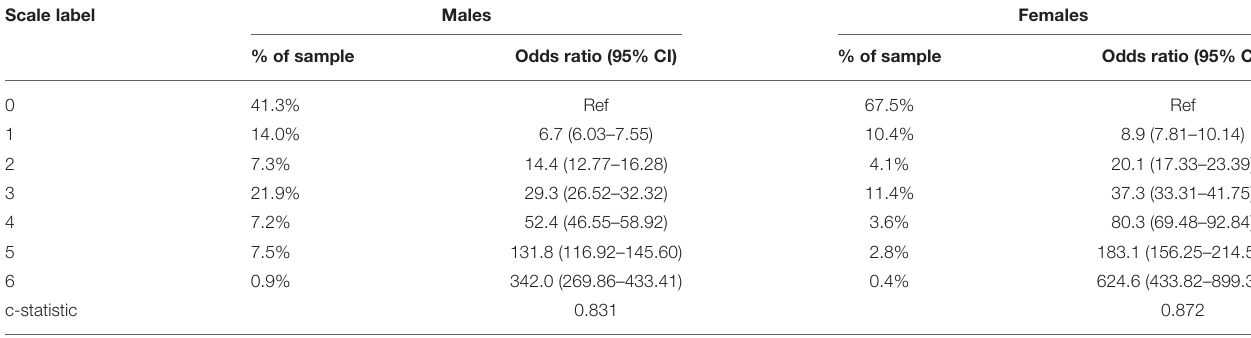
TABLE 4 | Risk of Injury to Others (RIO) algorithm by sex, derivation sample ( N = 60,414 screener assessments). Scale label